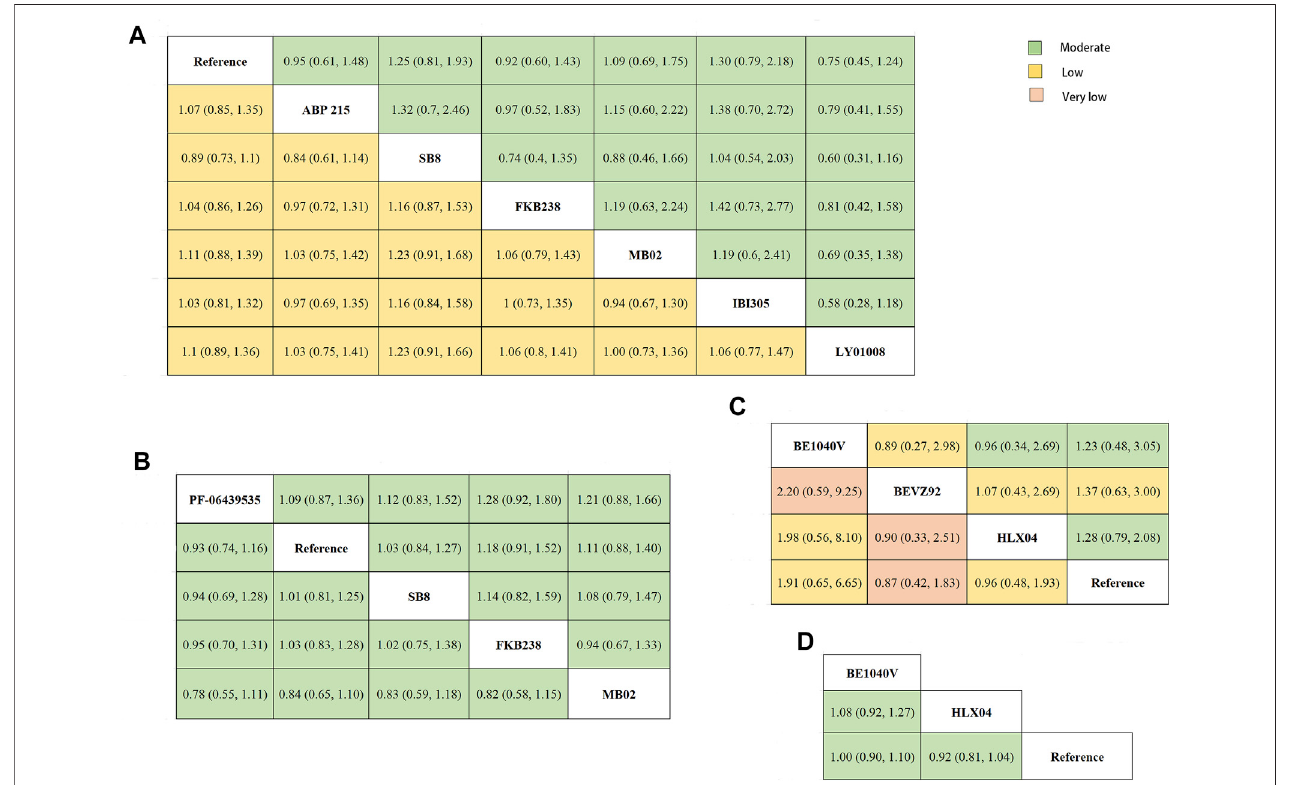
FIGURE 7 | League table. (A) The network estimate of objective response rate (lower-left) and the incidence rate of grade 3 – 5 adverse events (upper-right) in patients with non-small cell lung cancer. (B) The network estimate of progression-free survival (lower-left) and overall survival (upper-right) in patients with non-small cell lung cancer. (C) The network estimate of objective response rate (lower-left) and the incidence rate of grade 3 – 5 adverse events (upper-right) in colorectal cancer patients. (D) The network estimate of overall survival in colorectal cancer patients. The league table presented the relative effects of each biosimilar and reference biologics (the treatment on the column to the treatment of the row). The relative effects were measured as risk ratio for objective response rate, odds ratios for incidence ofgrade 3 – 5adverseevents,and hazard ratioforprogression-freesurvivalandoverallsurvival.The colorofeach cellindicatedthecertaintyofevidenceaccordingtothe Grading of Recommendations Assessment, Development, and Evaluation: green for moderate certainty, yellow for low certainty, and orange for very low certainty.